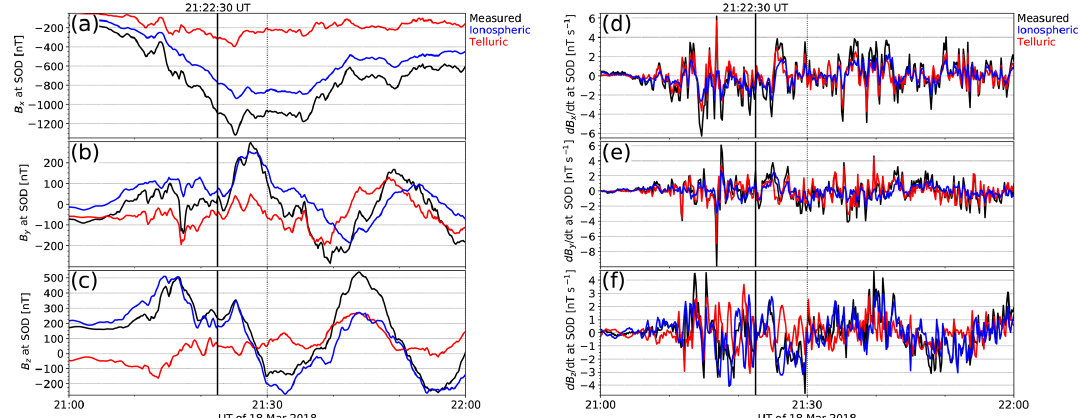
Figure 4. Magnetic field north component B x (a) and its time derivative d B x / d t (d) , east component B y and its time derivative d B y / d t (b, e) , and down component B z and its time derivative (c, f) at SOD as a function of UT for the event in Fig. 2. The measured value is plotted in black, the ionospheric contribution in blue, and the telluric contribution in red. The black vertical line indicates the time shown in Fig. 2.